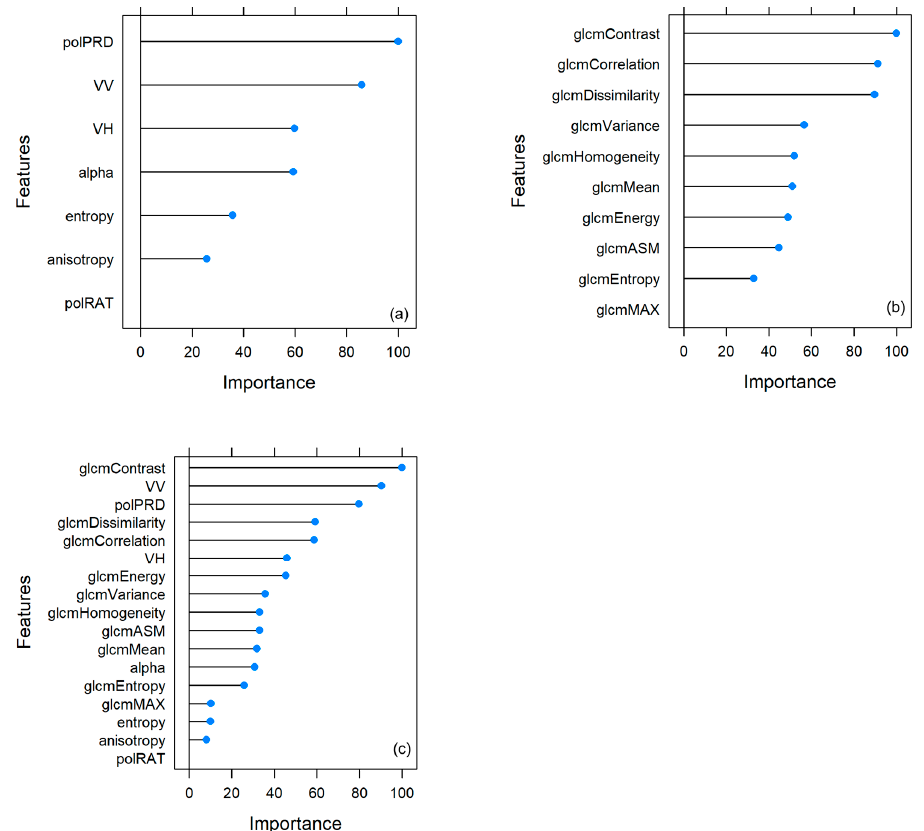
Figure 4. Rank of model features based on their contributions to improving the discrimination of C3, C4, and MX pasture grasses. The performance of each feature indicated on the x -axis, scaled to 100, when random forest classification model was created using: ( a ) polarimetric synthetic aperture radar features (polSAR), ( b ) textural features from grey-level co-occurrence matrix (glcmTEX), and ( c ) the combination of polSAR and glcmTEX features. The polSAR features are composed of backscatter values of VH polarization (VH) and backscatter values of VV polarization (VV), the product of VV and VH (polPRD) and the ratio of VV to VH (polRAT). The other polSAR features are the eigenvector polarimetric decomposition parameters including entropy, anisotropy, and alpha. The glcmTEX features are prefixed with ‘glcm.’ The ASM denotes the angular second moment whereas MAX denotes the maximum